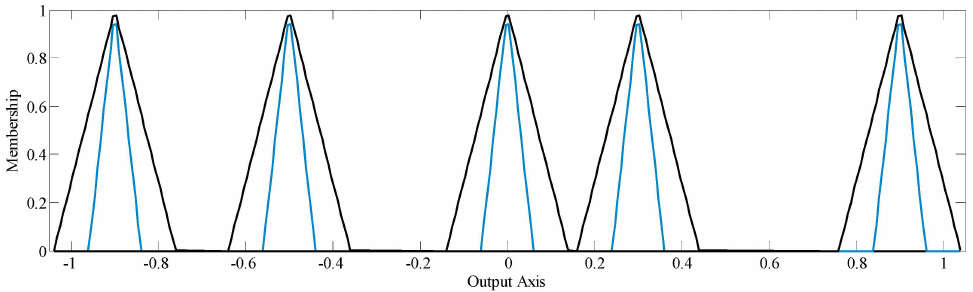
Figure 5. Output membership fuctions.